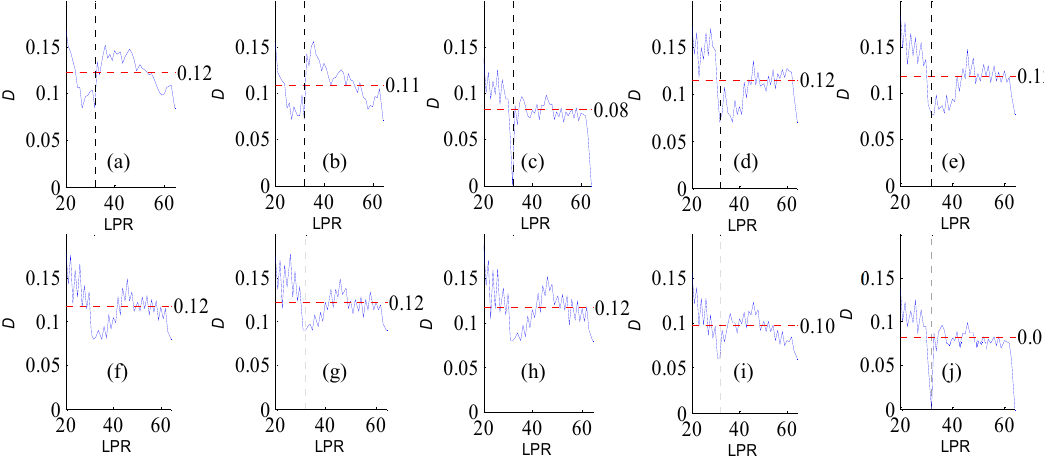
Figure A16. Variation of flow regime alteration degree (D) measured by the RVA with change in the length of post-impact flow time series (LPR) under a periodicity of 32 years. ( a – j ) correspond to pre-impact flow time series length = 23, 27, 32, 37, 41, 46, 50, 55, 59, and 64 years, respectively. The abscissa value for the vertical dotted line is 32. The ordinate value for the horizontal dotted line is the mean degree of flow regime alteration in each subfigure.